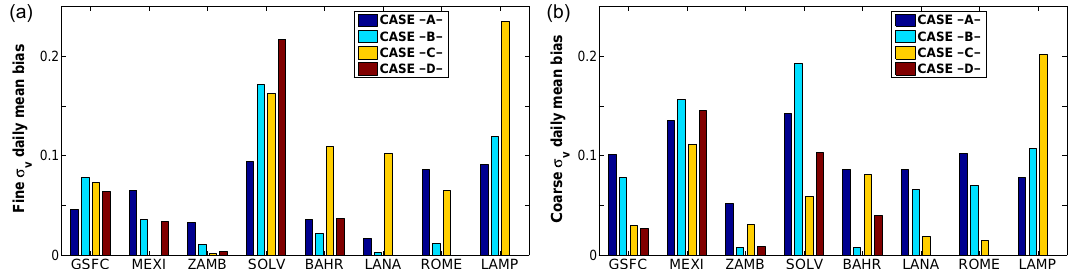
Figure 12. Absolute differences between the daily averages of the mode standard deviation retrieved by GRASP-AOD and AERONET standard inversions (total values can be found in Table 14) for the examples considered in the analysis as listed in Table 13. The differences for the fine mode are represented in the left panel and for the coarse mode in the right panel. Different days (A, B, C and possibly D) considered at each station and plotted with different